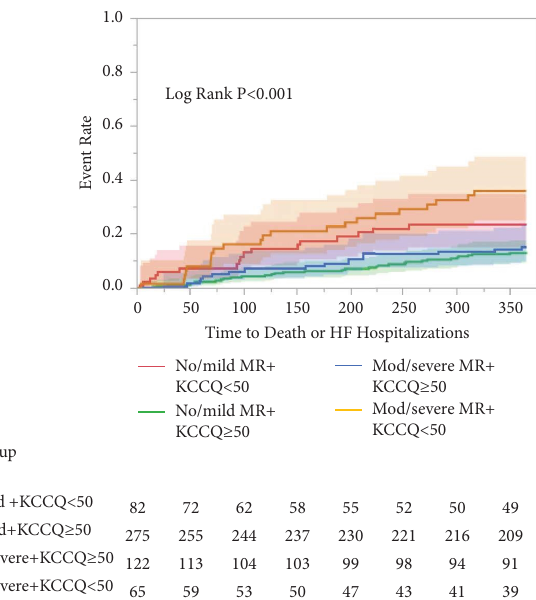
Figure 4: Kaplan–Meier survival estimates for mortality or heart failure hospitalizations at 1 year follow-up according to the 30-day KCCQ score and regurgitant degree of the mitral valve. Plots reveal a higher incidence of the primary endpoint among the lower KCCQ group regardless of procedural success (red and orange curves).